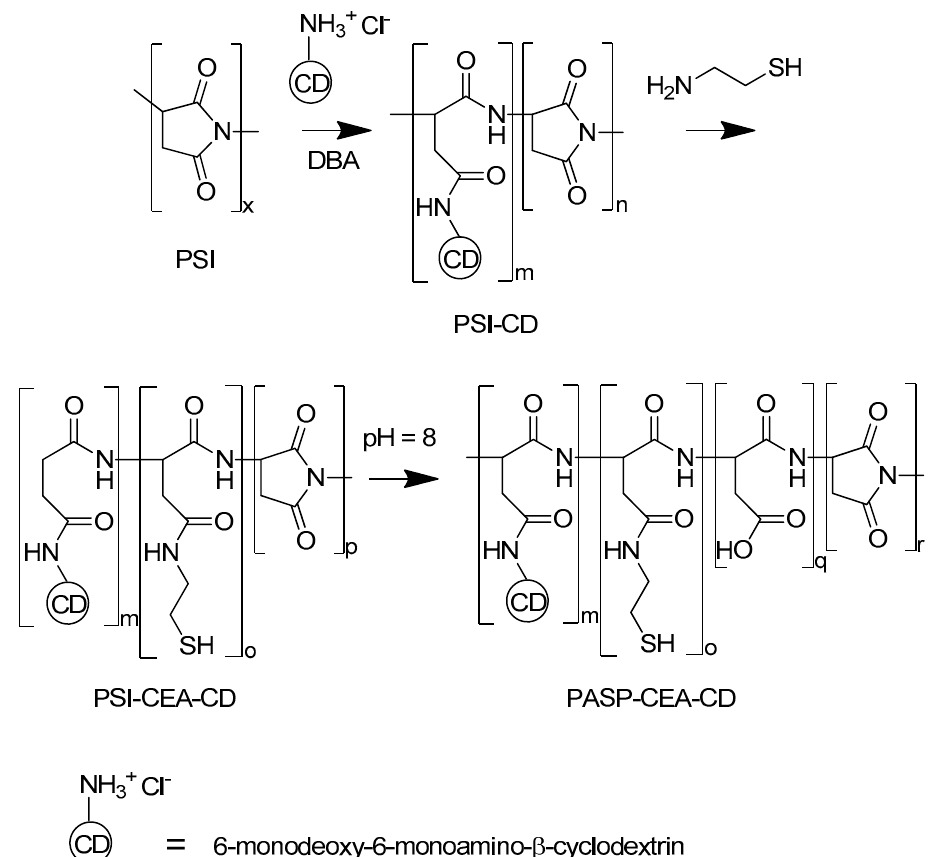
Figure 1. Synthesis of thiol and cyclodextrin functionalized poly(aspartic acid).